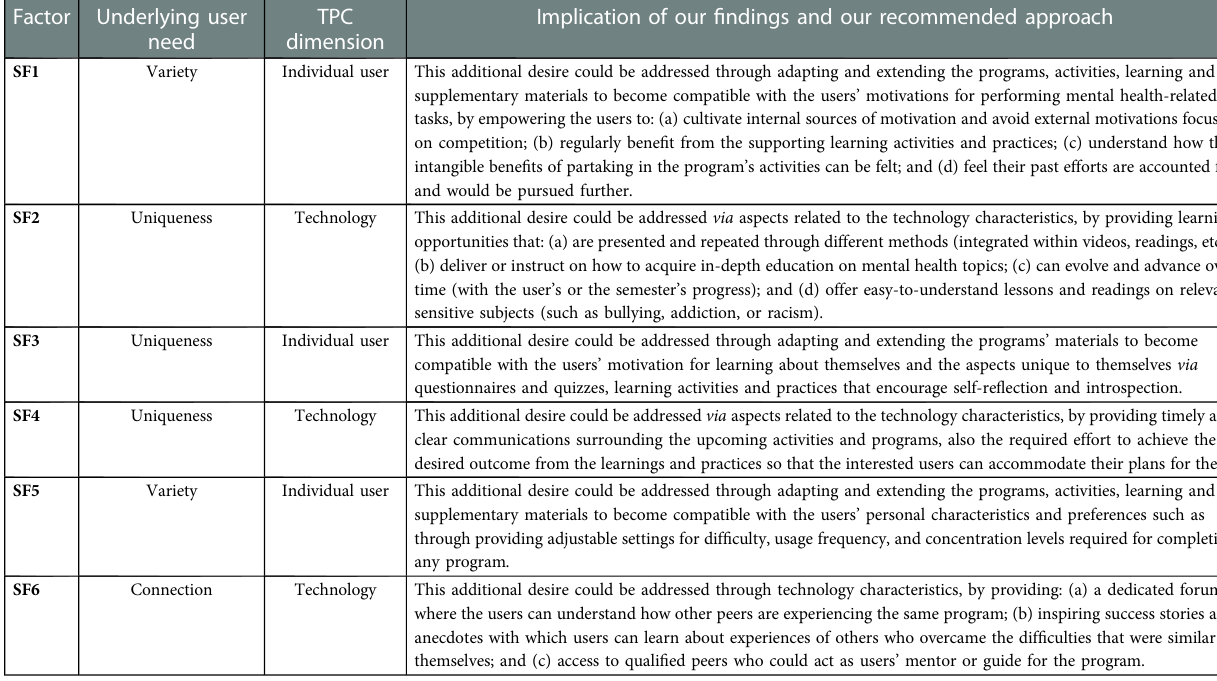
TABLE 2 Implications of the identi fi ed secondary engagement factors and our recommendations.